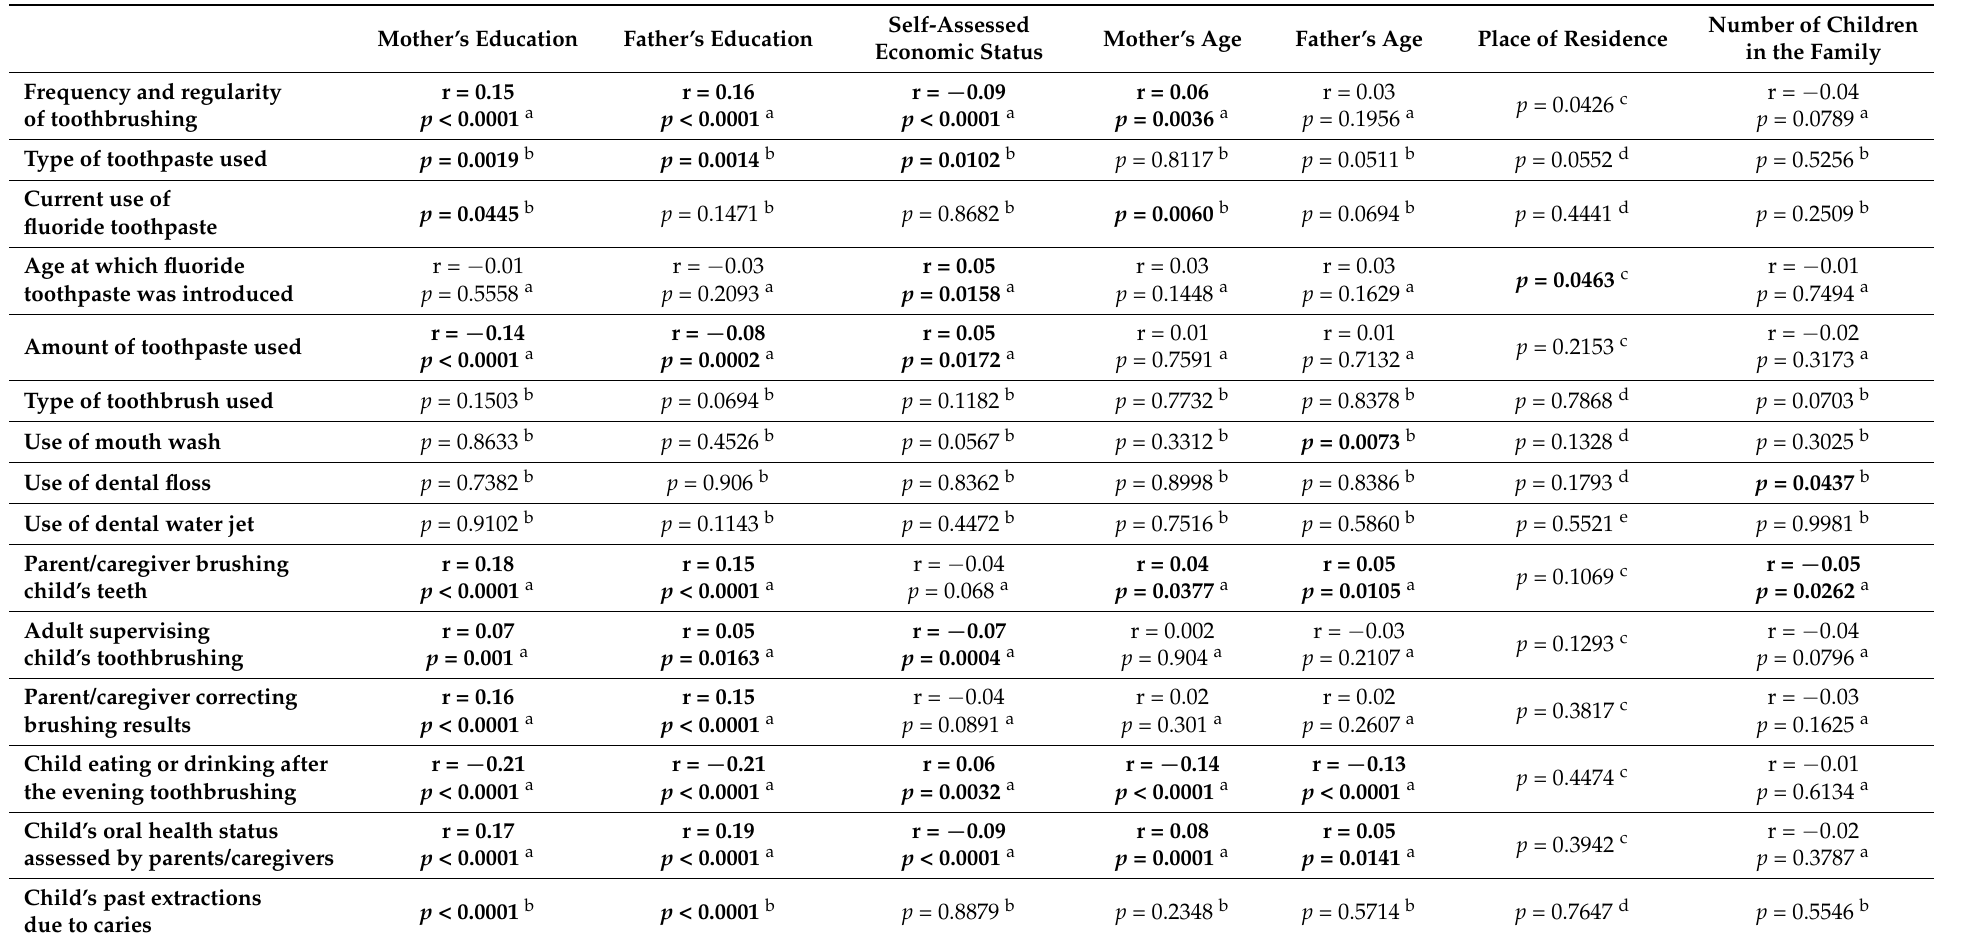
Table 3. Selected socioeconomic factors vs. children’s oral health practices and status according to